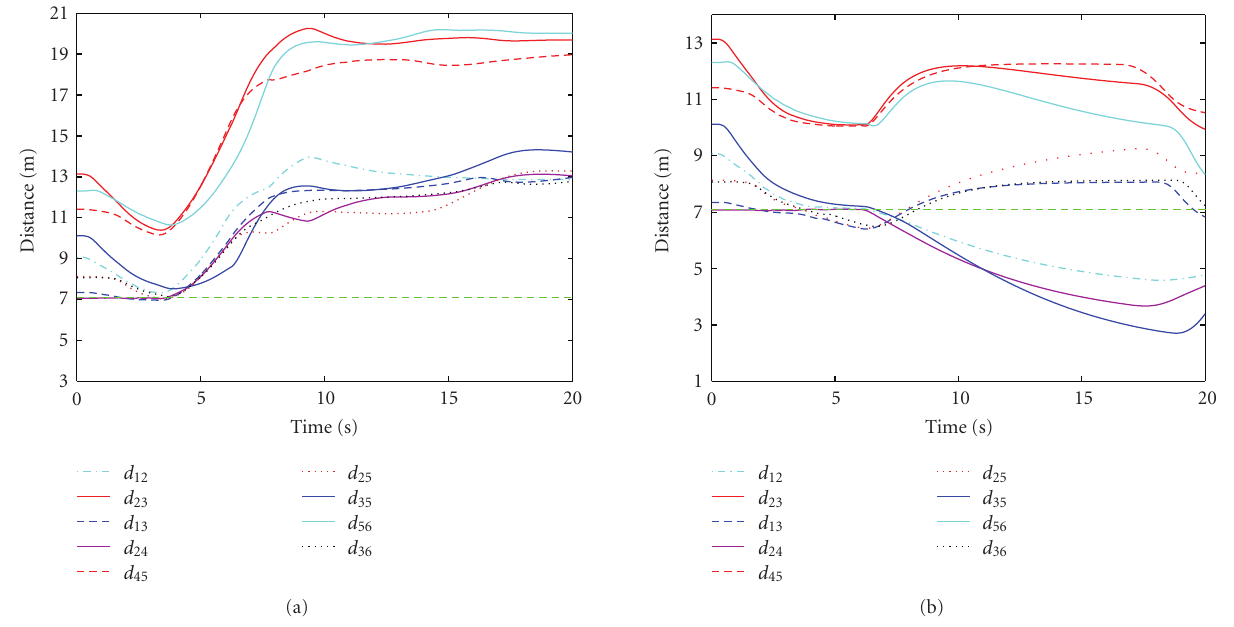
Figure 10: Distances between each pair of vehicles for Algorithm 2 (a) and Algorithm 1